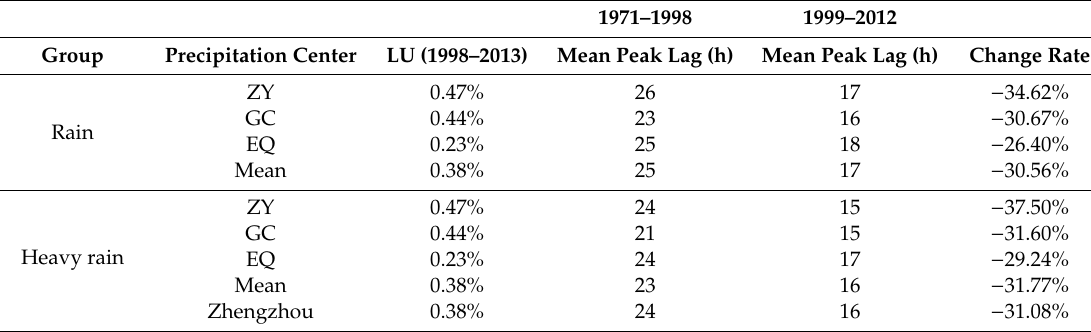
Table 5. Peak lag statistics.